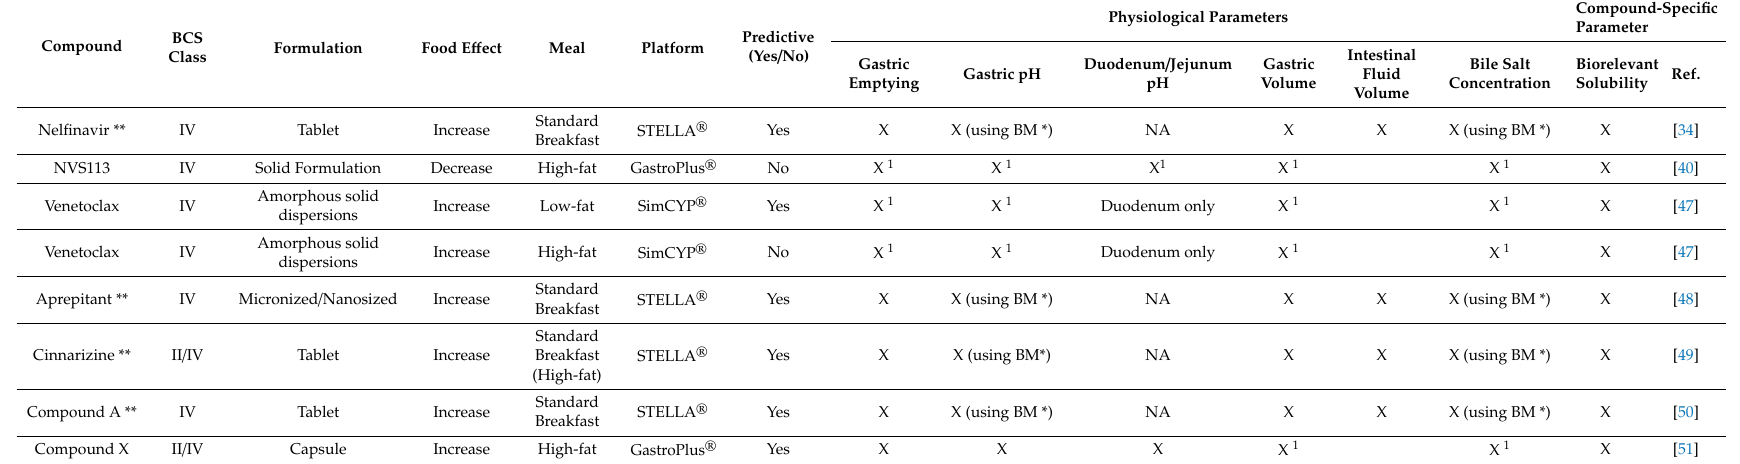
Physiological Parameters Compound-Specific